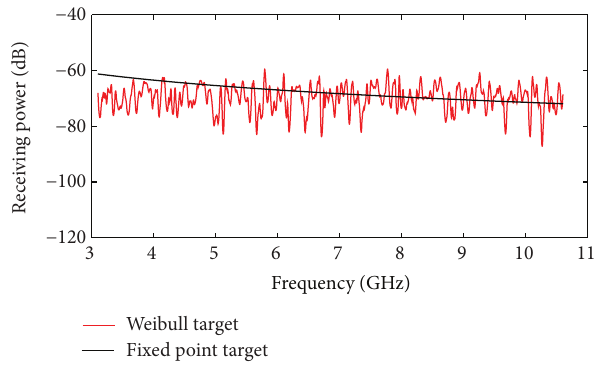
Figure 9: Simulated RCS of a simulated Weibull target in com- parison with a fixed point target considering propagation loss in frequency domain.